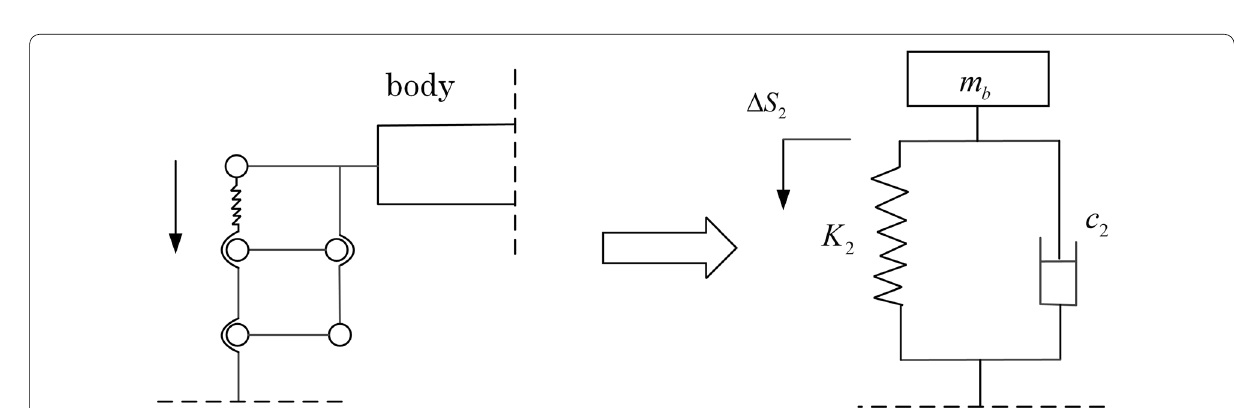
Figure 17 One DOF equivalent vibration model of the second-stage buffer